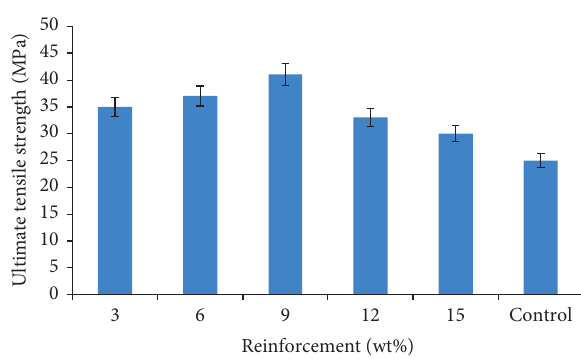
Figure 3: Variation in the ultimate tensile strength of the devel- oped composites and the